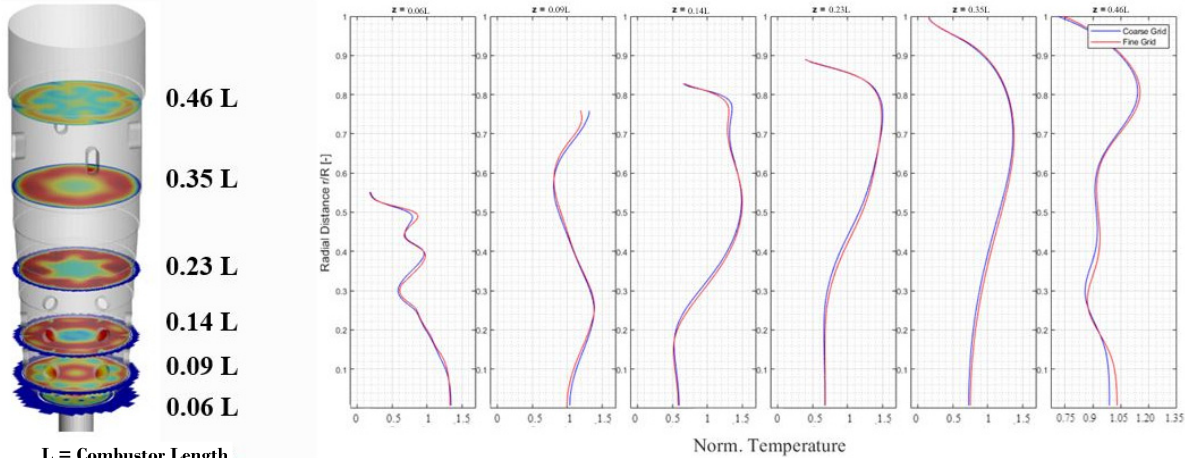
Figure 4. Normalized temperature mean radial distribution at different axial positions for base and refined grid.